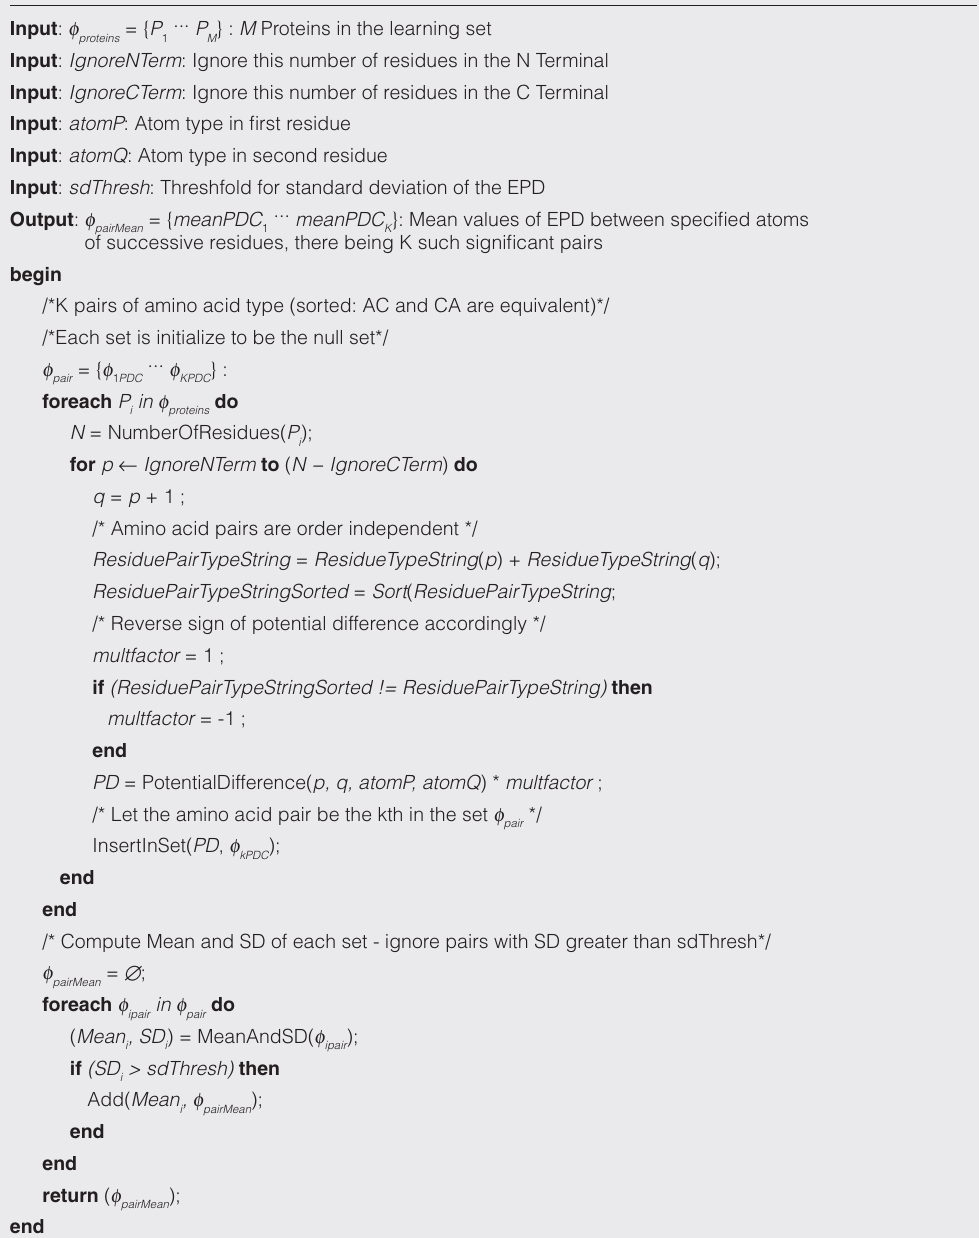
Algorithm 1. LearnFeatures(): extract electrostatic potential difference (EPD) values from a given pair of amino